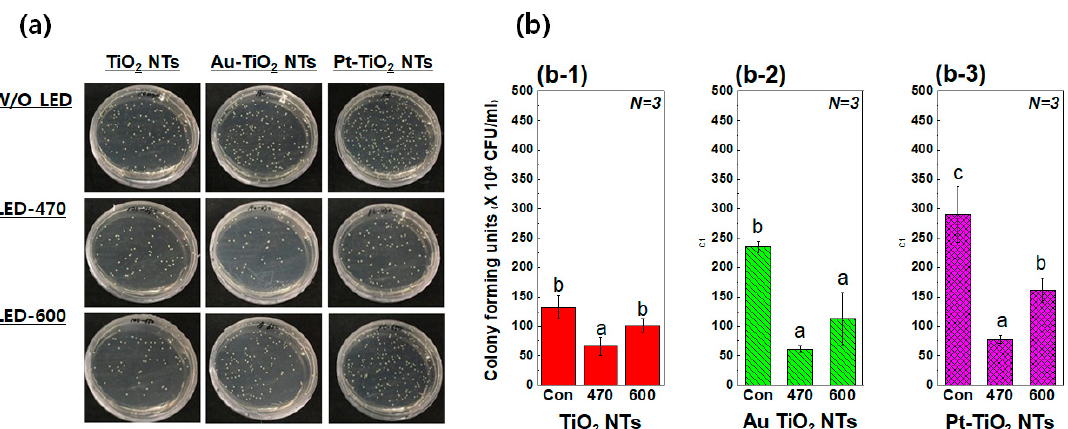
Figure 5. ( a ) Photographs of antibacterial Streptococcus aureus agar diffusion tests and ( b ) the results of colony forming units (CFUs) per unit volume of Streptococcus aureus cultured on ( b-1 ) TiO 2 NTs, ( b-2 ) Au–TiO 2 NTs, and ( b-3 ) Pt–TiO 2 NTs with or without 470 nm and 600 nm visible light irradiation (“Con”: No irradiation, “470”: 470 nm irradiation, “600”: 600 nm irradiation) (in each graph, entries with the same lowercase letters were not significantly different as determined by one-way ANOVA at α = 0.05).